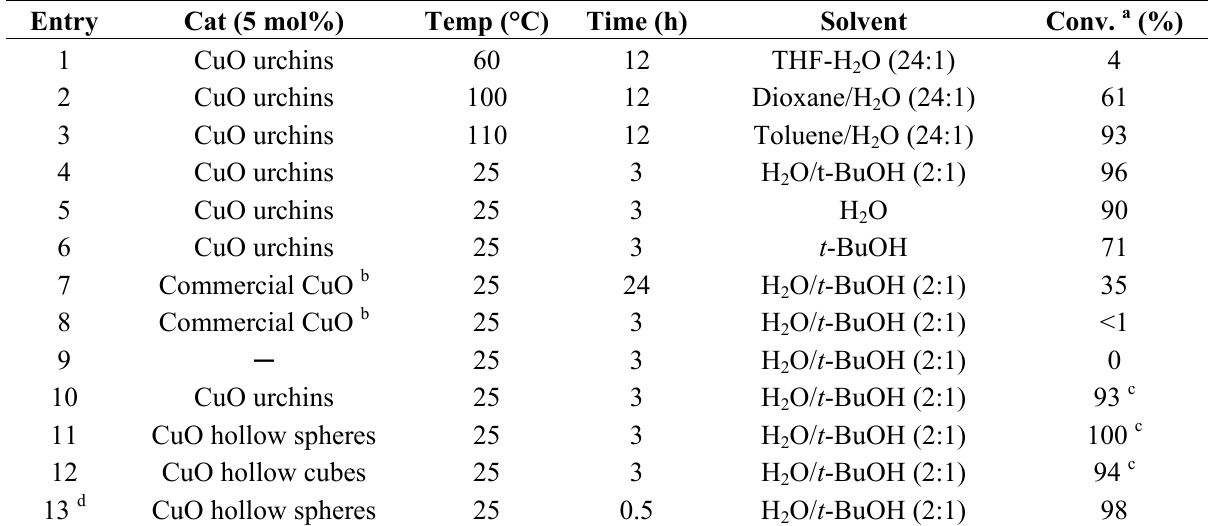
Table 1. Optimization of click reaction catalyzed by various CuO(II)